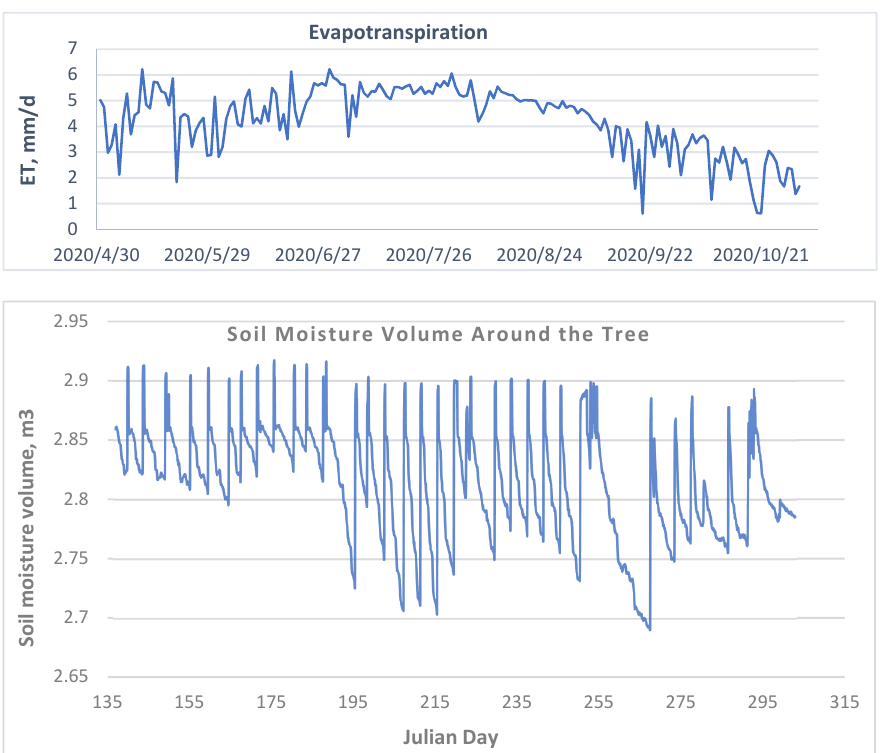
Figure 7. Evapotranspiration (ET) propagation and corresponding soil moisture profile responsive to ET and irrigation/precipitation events.